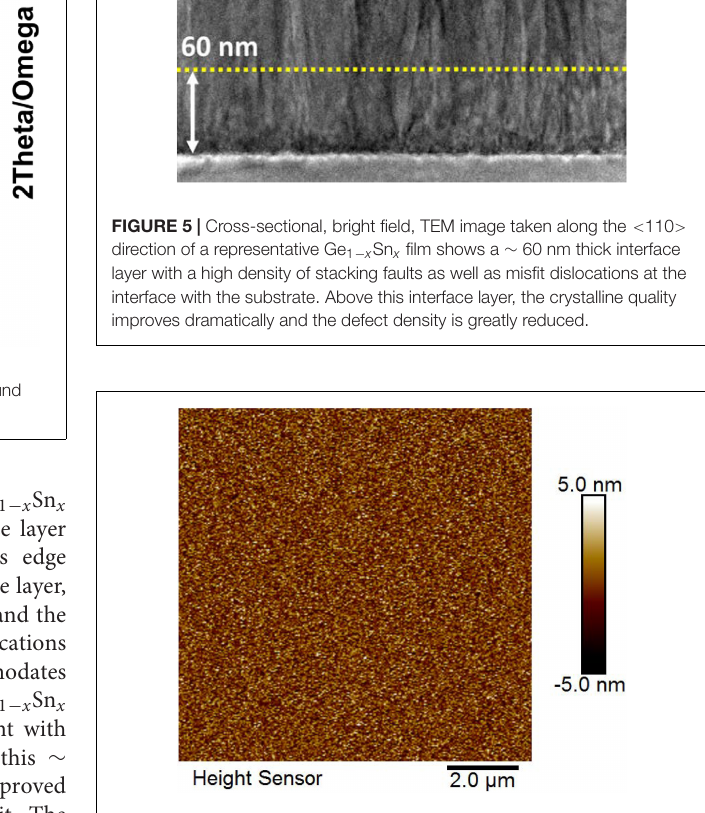
typically seen for Ge films grown on Si is not